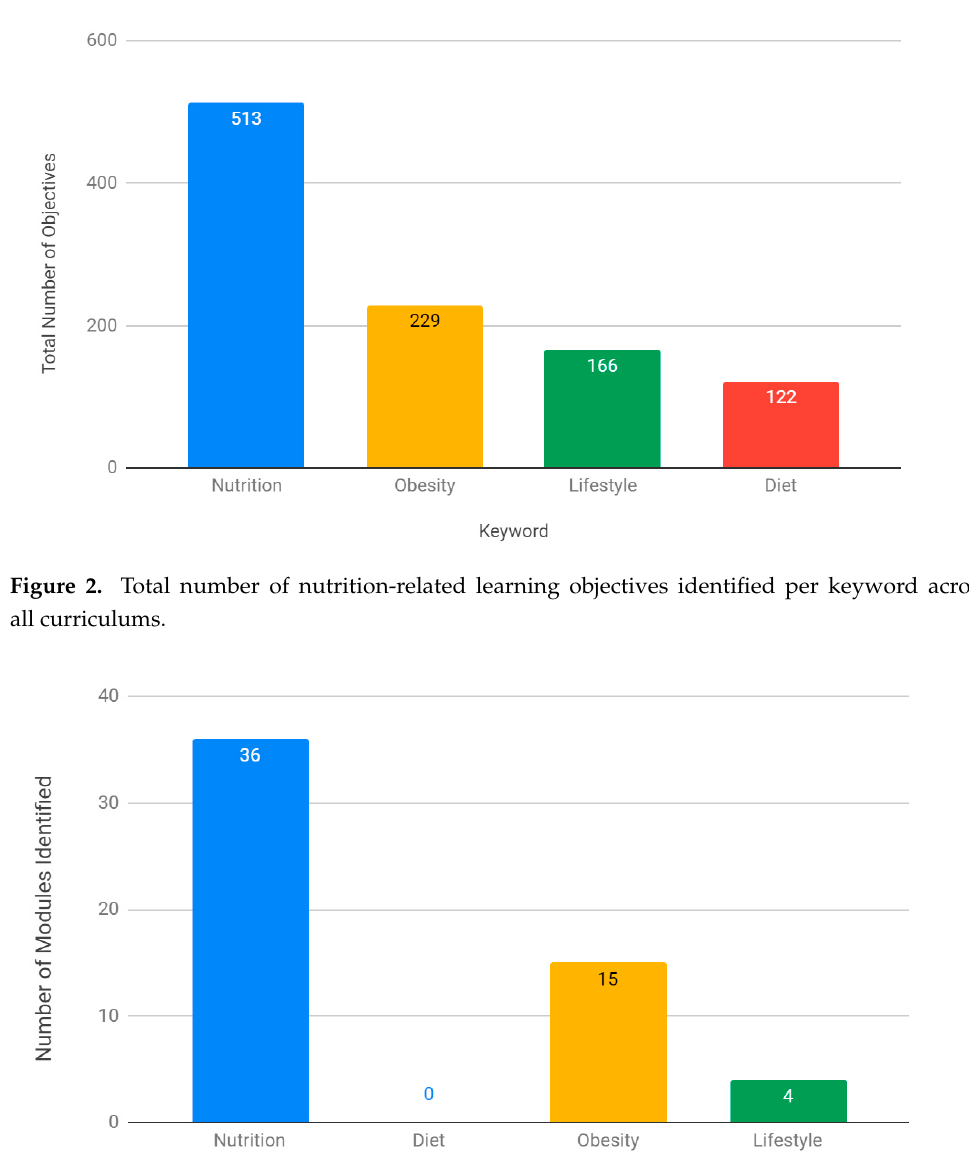
Figure 4. Proportion of nutrition-related objectives designated as knowledge-, skill-, and behav- iour-based outcomes. Over half of ‘nutrition’ and ‘obesity’ objectives were knowledge-based, with a small proportion of behaviour-based objectives (8.4% and 4.4%, respectively) (Figure 5). In com- parison, ‘diet’ and ‘lifestyle’ objectives had the highest proportion of behaviour-based out- comes (21.3% and 29.1%, respectively) though these outcomes still remained a minority. ‘Diet’ objectives had the highest proportion of skill-based outcomes (41.5%).